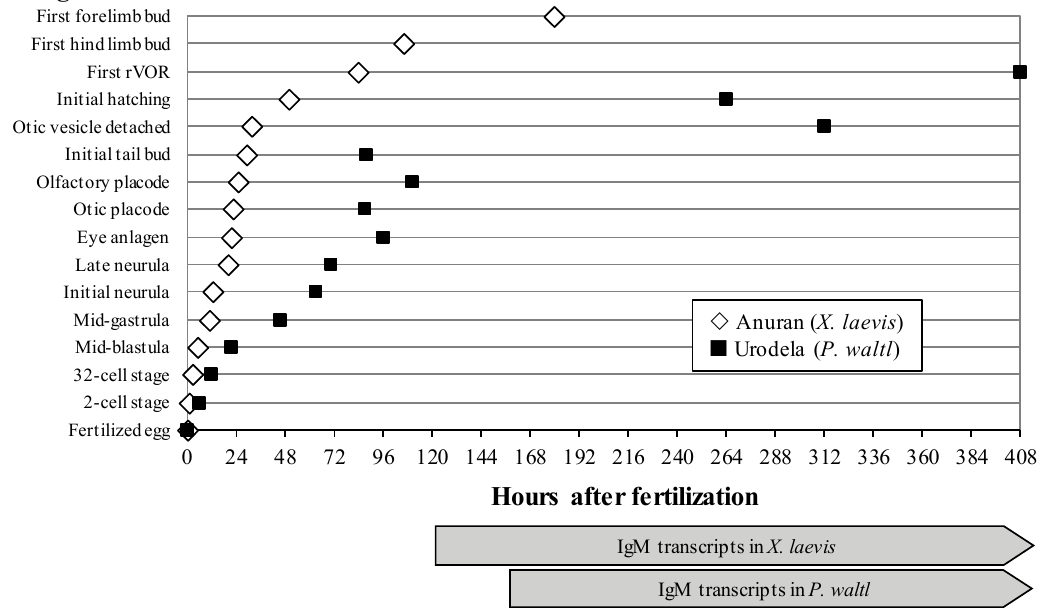
Figure 1. Comparison of anuran and urodela embryo developmental rates using X. laevis and P. waltl as examples. Gray arrows indicate the expression of IgM heavy-chain transcripts in both species. rVOR: vestibuloocular reflex. Adapted from [18] and [44] with the permission of Elsevier Ltd. and John Wiley and Sons.